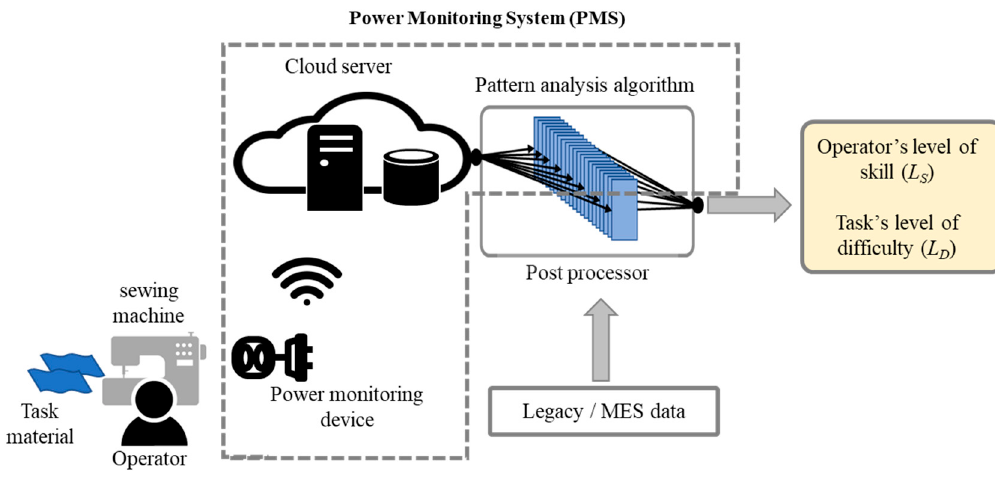
Figure 3. Power monitoring system for remote sensing of sewing work. MES: Manufacturing execution system.